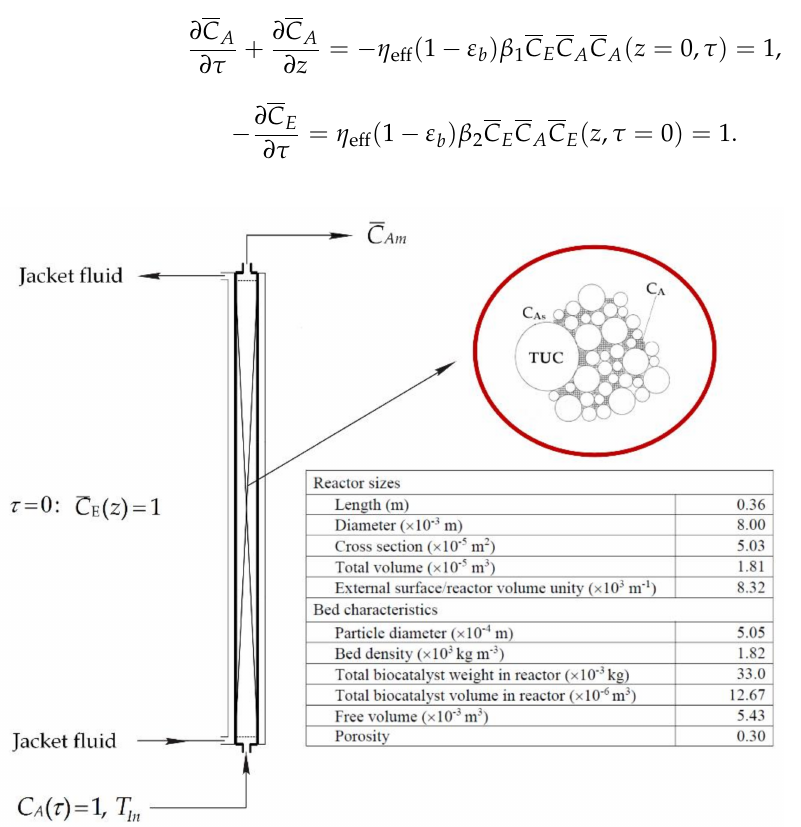
Figure 8. Schematic diagram of FXBR for decomposition process of